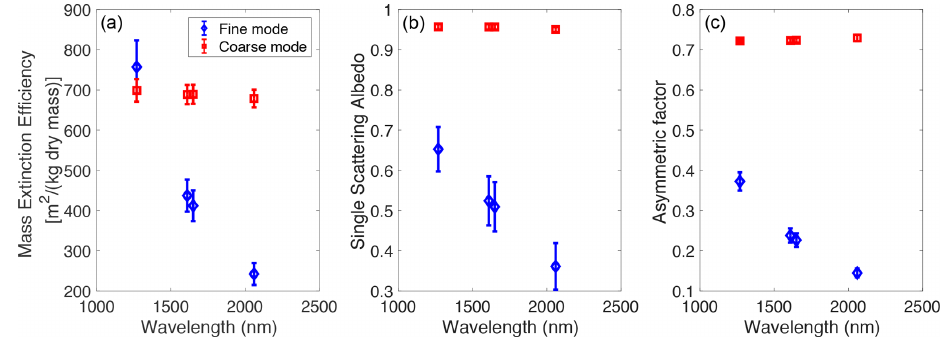
Figure 7. Wavelength dependence of aerosol optical properties (averaged over a year) in the 1.27µm O 2 1 (cid:49) absorption band, 1.61µm weak CO 2 absorption band, 1.65µm CH 4 absorption band, and 2.06µm strong CO 2 absorption band from the Georgia Institute of Technology– Goddard Global Ozone Chemistry Aerosol Radiation and Transport (GOCART) model. (a) Mass extinction efficiency, (b) single scattering albedo, and (c) asymmetry factor for fine (blue) and coarse (red) modes. These aerosol optical properties are density weighted on a monthly basis for daytime only (07:00, 10:00, 13:00, 16:00LT). For aerosols that are hygroscopic (size dependent upon relative humidity), monthly average humidity is